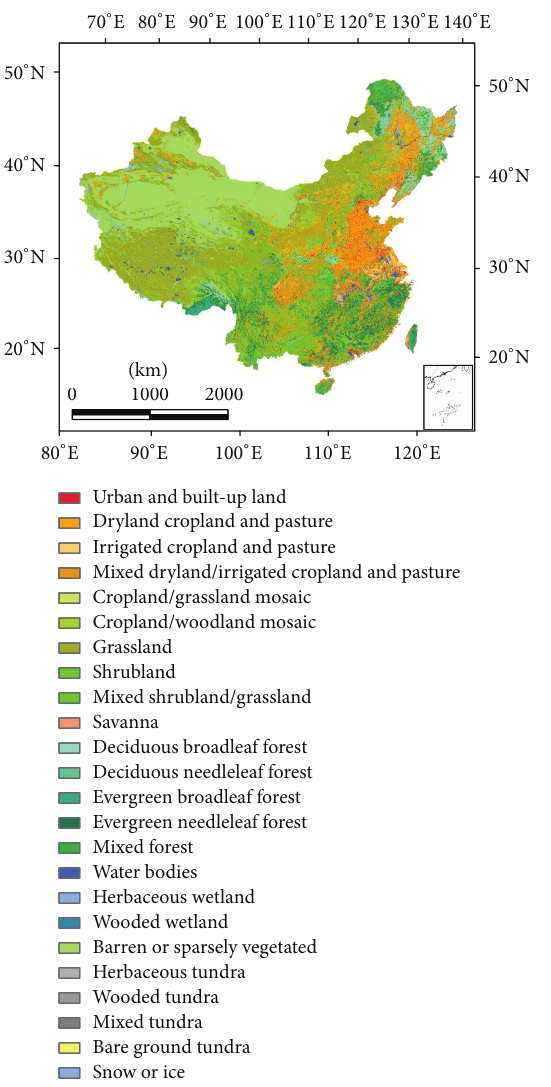
Figure 1: Land use/cover data with USGS classification system in 2000 in